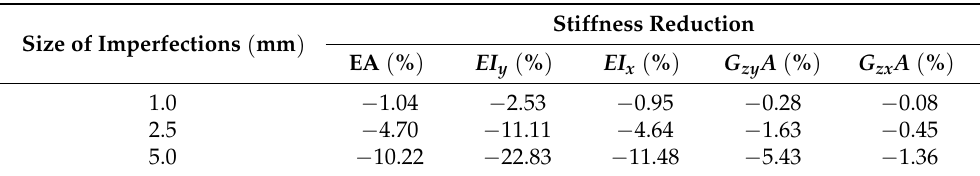
Table 5. Stiffness reduction of Z profile with an elongation of 100 mm due to bending about the vertical axis for (i) case, depending on the size of imperfections.